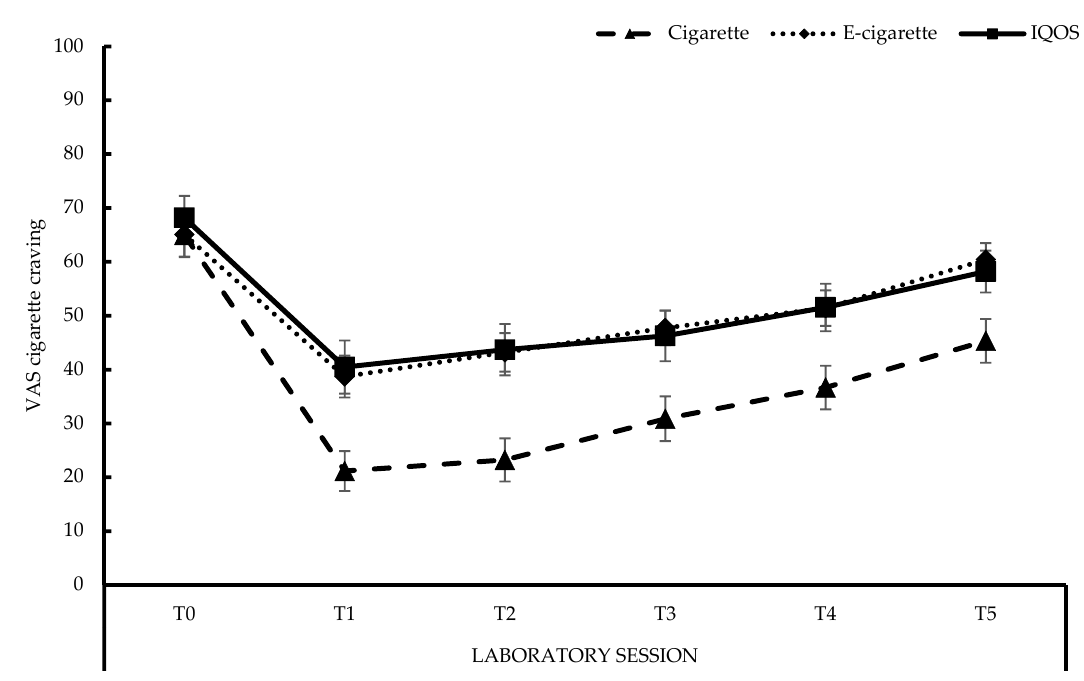
Figure 3. Visual Analogue Scale (VAS) cigarette craving. Cigarette : M T0 ( SE between brackets) = 65.00 (4.13), M T1 = 21.17 (3.71), M T2 = 23.23 (4.01), M T3 = 30.87 (4.17), M T4 = 36.67 (4.06), M T5 = 45.33 (4.05); E-cigarette : M T0 = 65.07 (4.07), M T1 = 38.70 (3.88), M T2 = 43.20 (3.57), M T3 = 47.73 (3.21), M T4 = 51.40 (3.29), M T5 = 60.43 (3.05); IQOS TM : M T0 = 68.17 (4.08), M T1 = 40.47 (4.94), M T2 = 43.70 (4.77), M T3 = 46.27 (4.71), M T4 = 51.53 (4.40), M T5 = 58.20 (3.89).